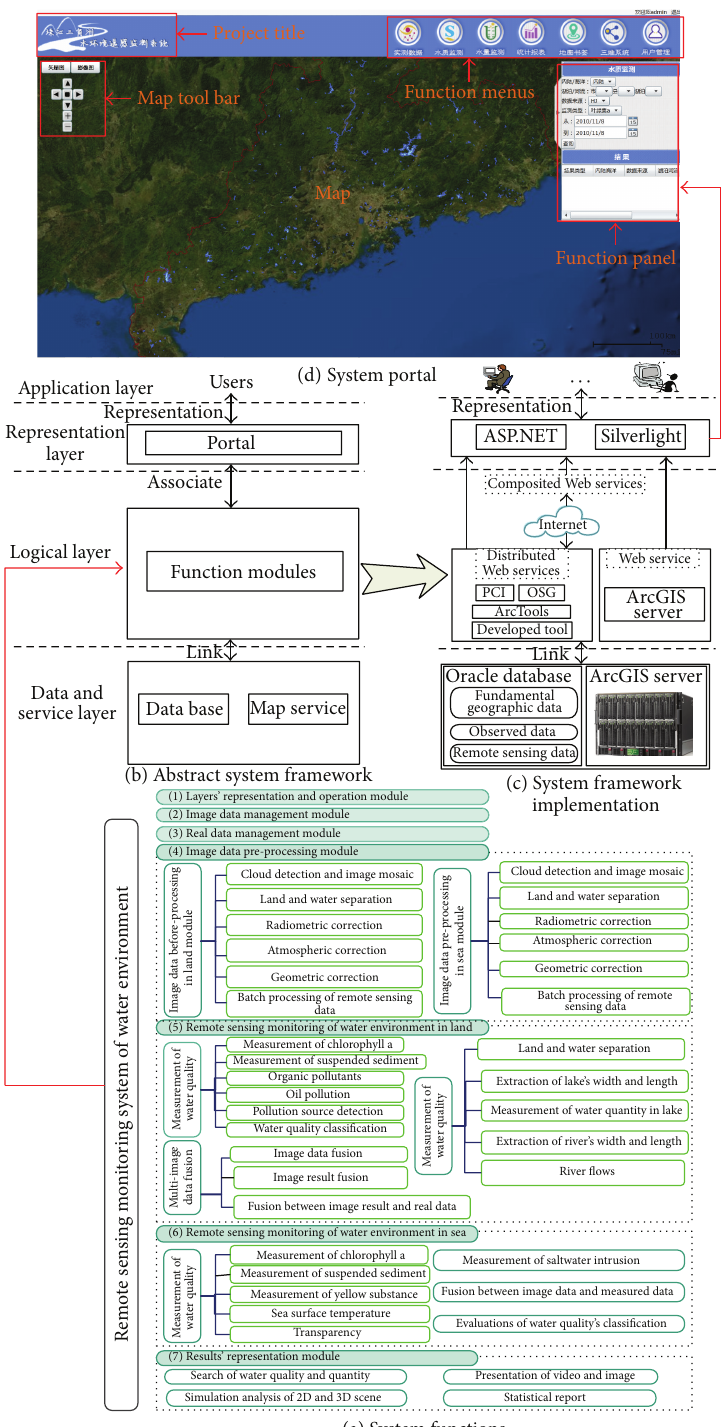
Figure 8: The system functions and system